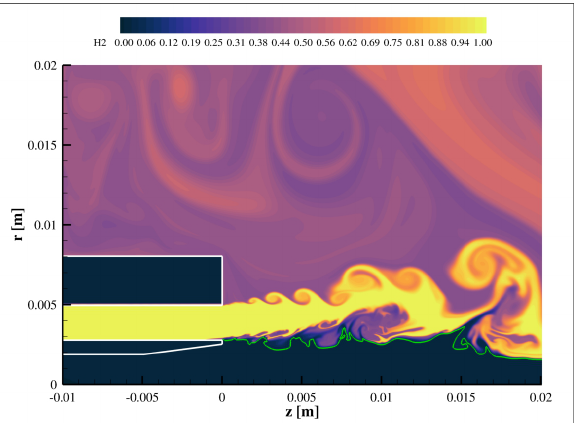
Figure 14. Numerical instantaneous distribution of the H 2 mass fraction at the same time as Figure 9; the stoichiometric mixture fraction isoline Z = 0.11 is also shown in green.